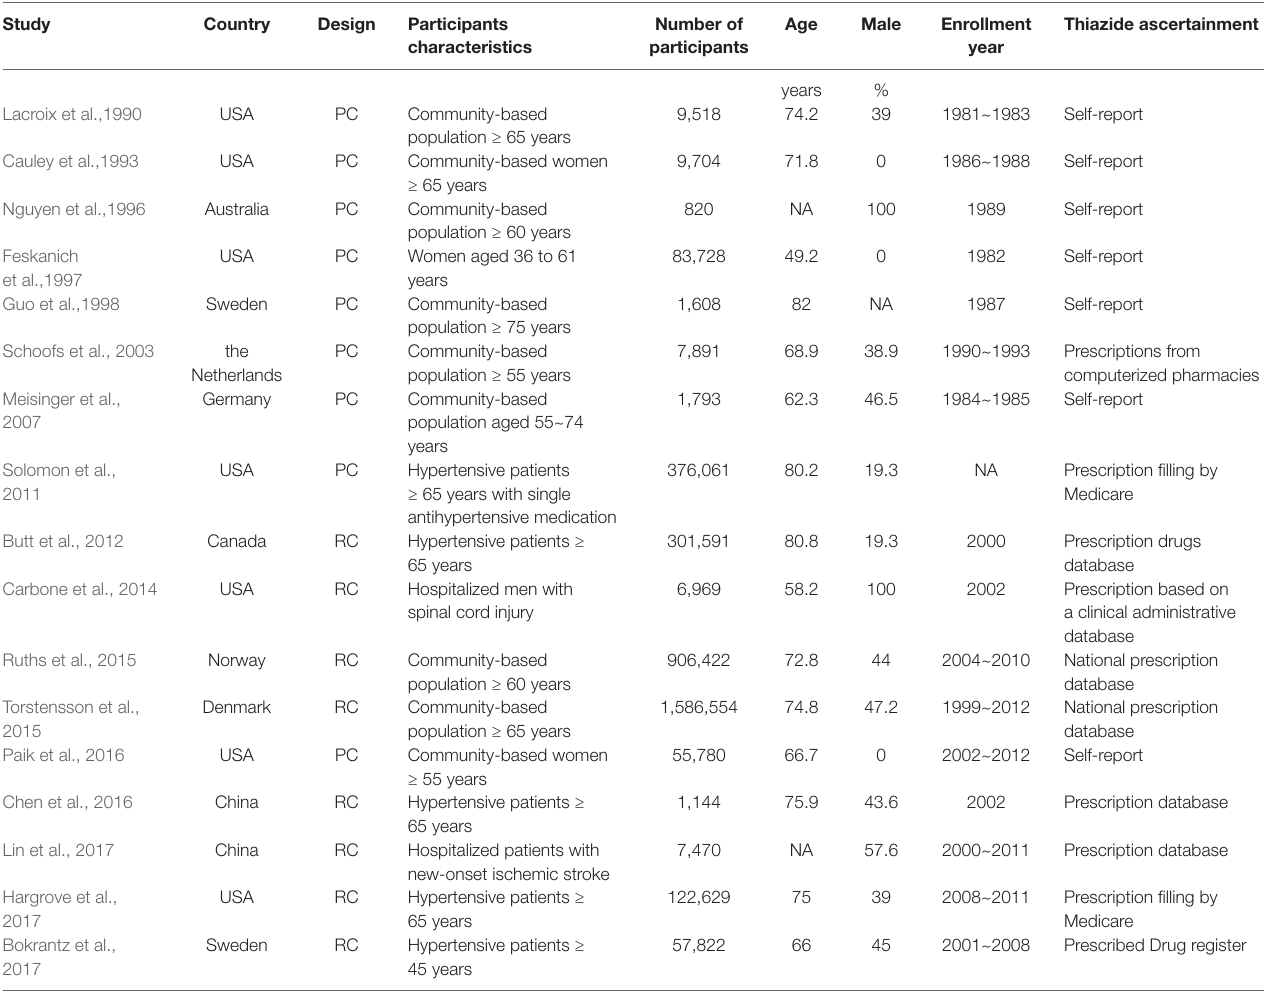
TABLe 1 | Baseline characteristics of the included